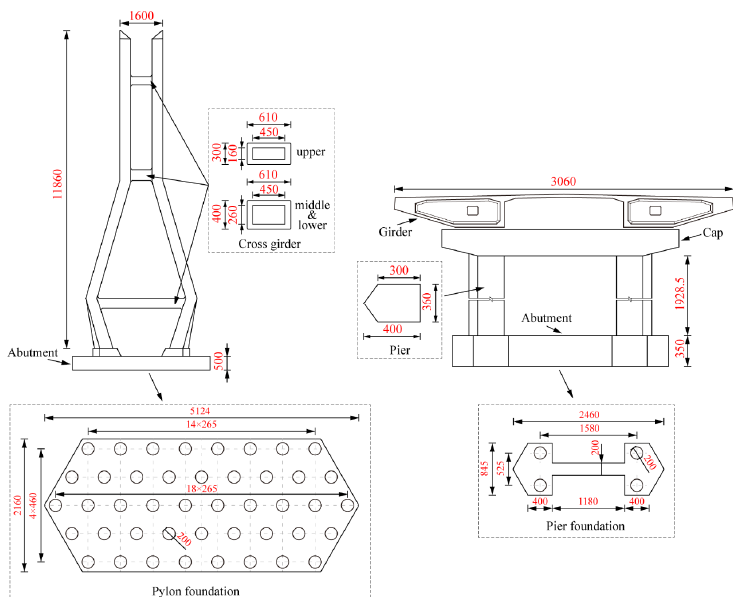
Figure 3. Dimension of the bridge components (unit: cm).